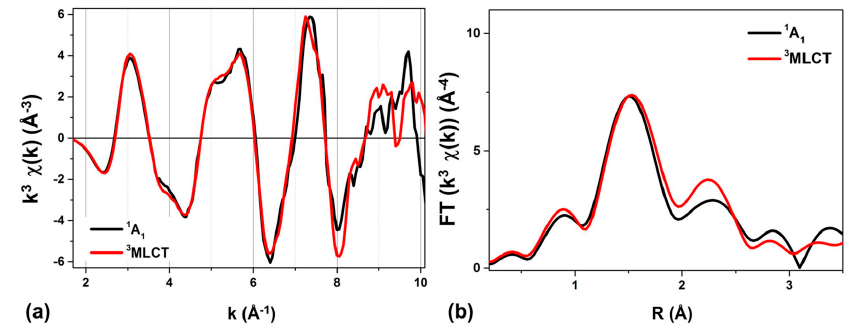
Figure 3. Cont. Figure 3.